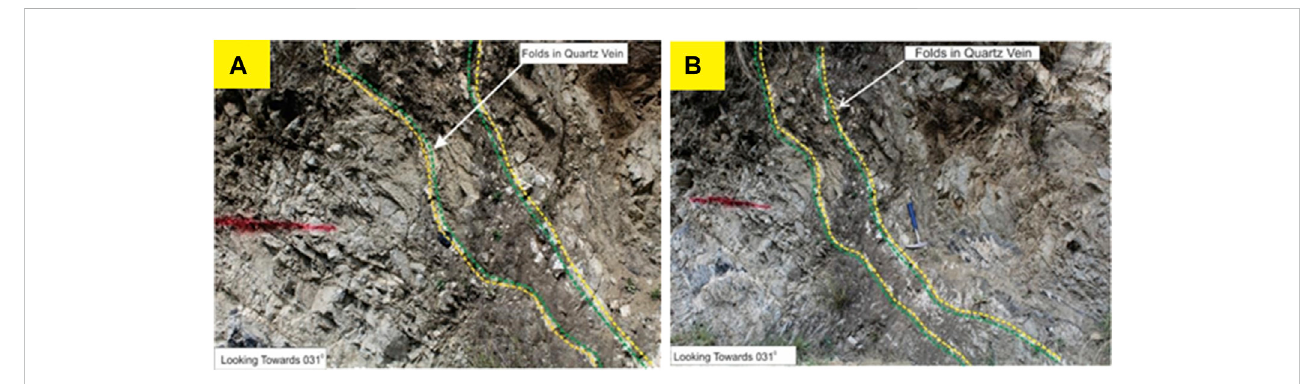
FIGURE 6 (A,B) Outcrop folding in the form of quartz/feldspar vein (drag fold) and Figure 14 Outcrop showing gentle fold with strike 031 and a dip angle of 54.